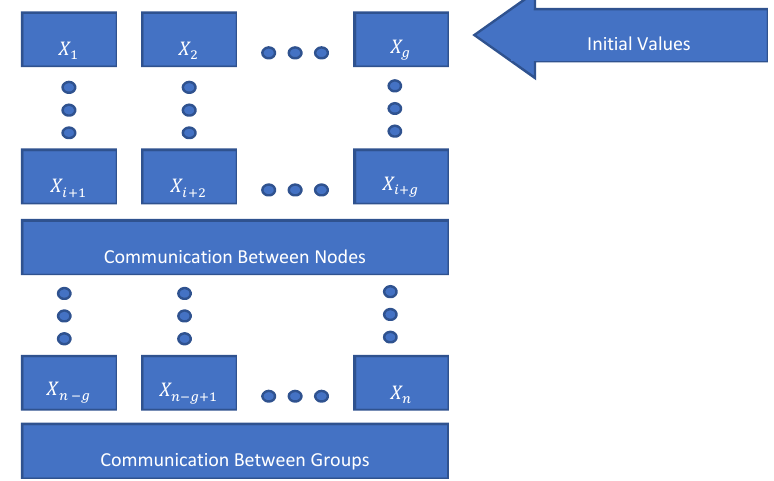
Figure 4. Scheduling scheme within / by the ODECCL system. Inside a group of processors, a stage will be processed, and between groups, steps will be calculated and